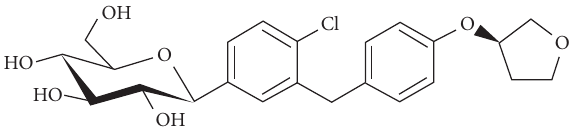
Figure 1: Chemical structure of empagliflozin